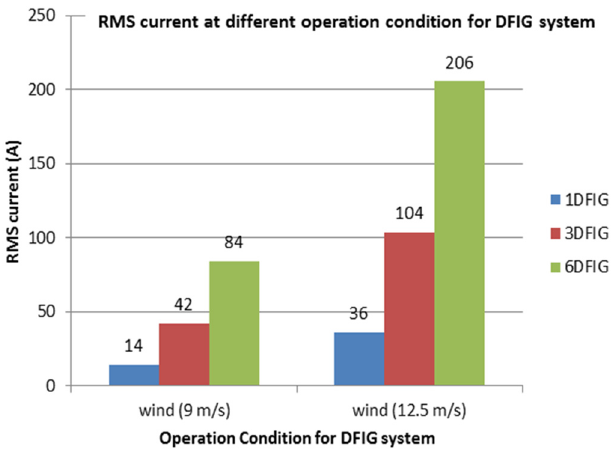
Figure 2. Bar chart representing the variation in loading current at the DFIG system.